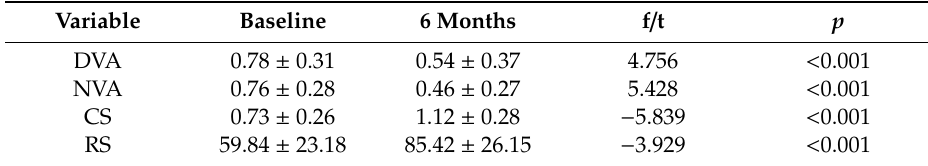
Table 1. Visual functions of polypoidal choroidal vasculopathy (PCV) study eyes at baseline and 6 months after